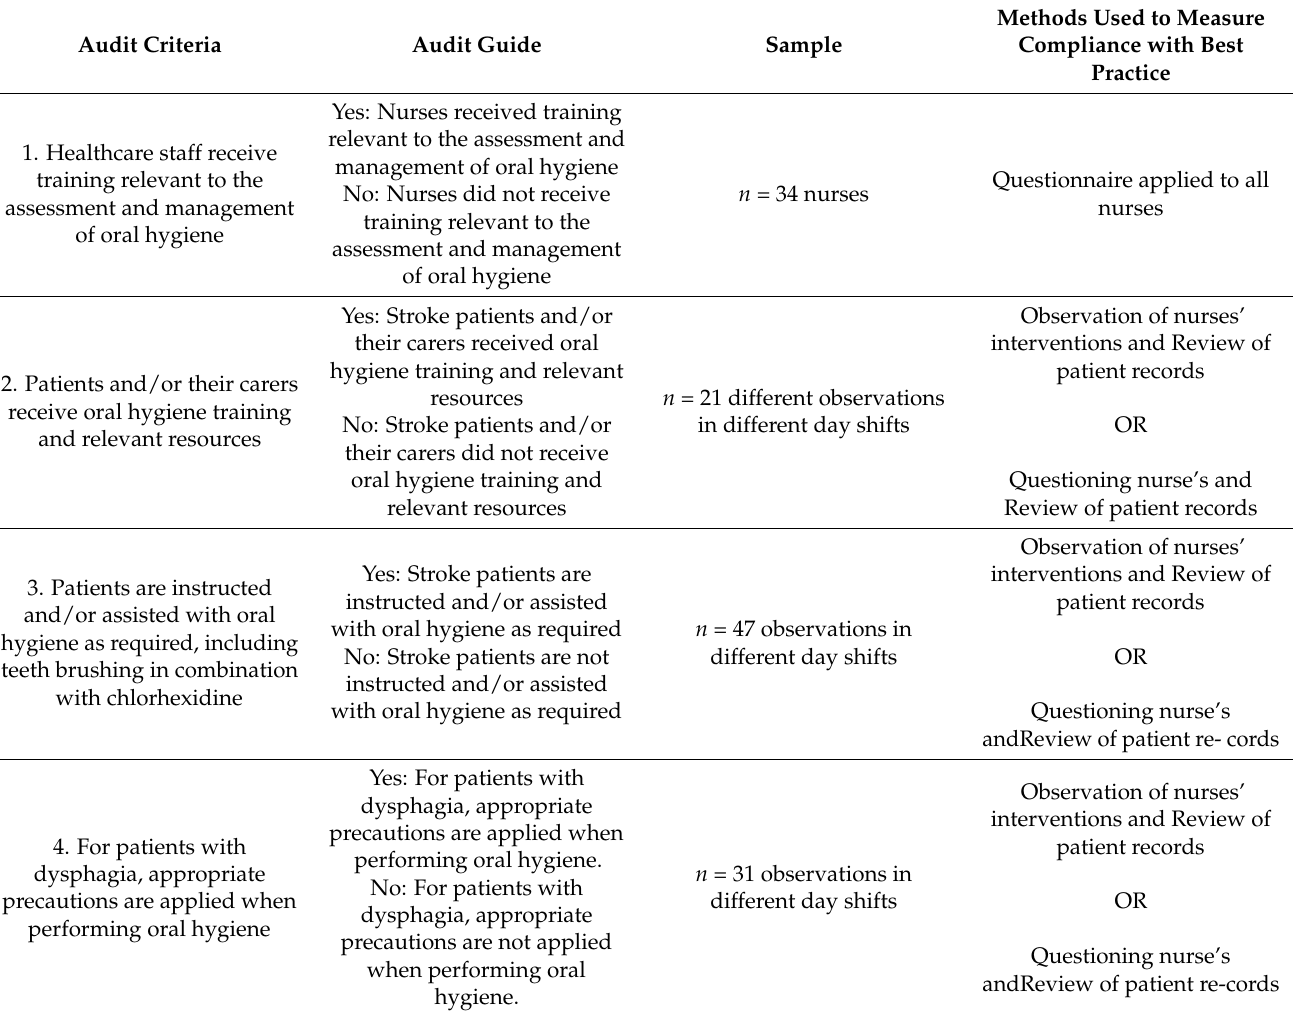
Table 2. Audit criteria, sample, and